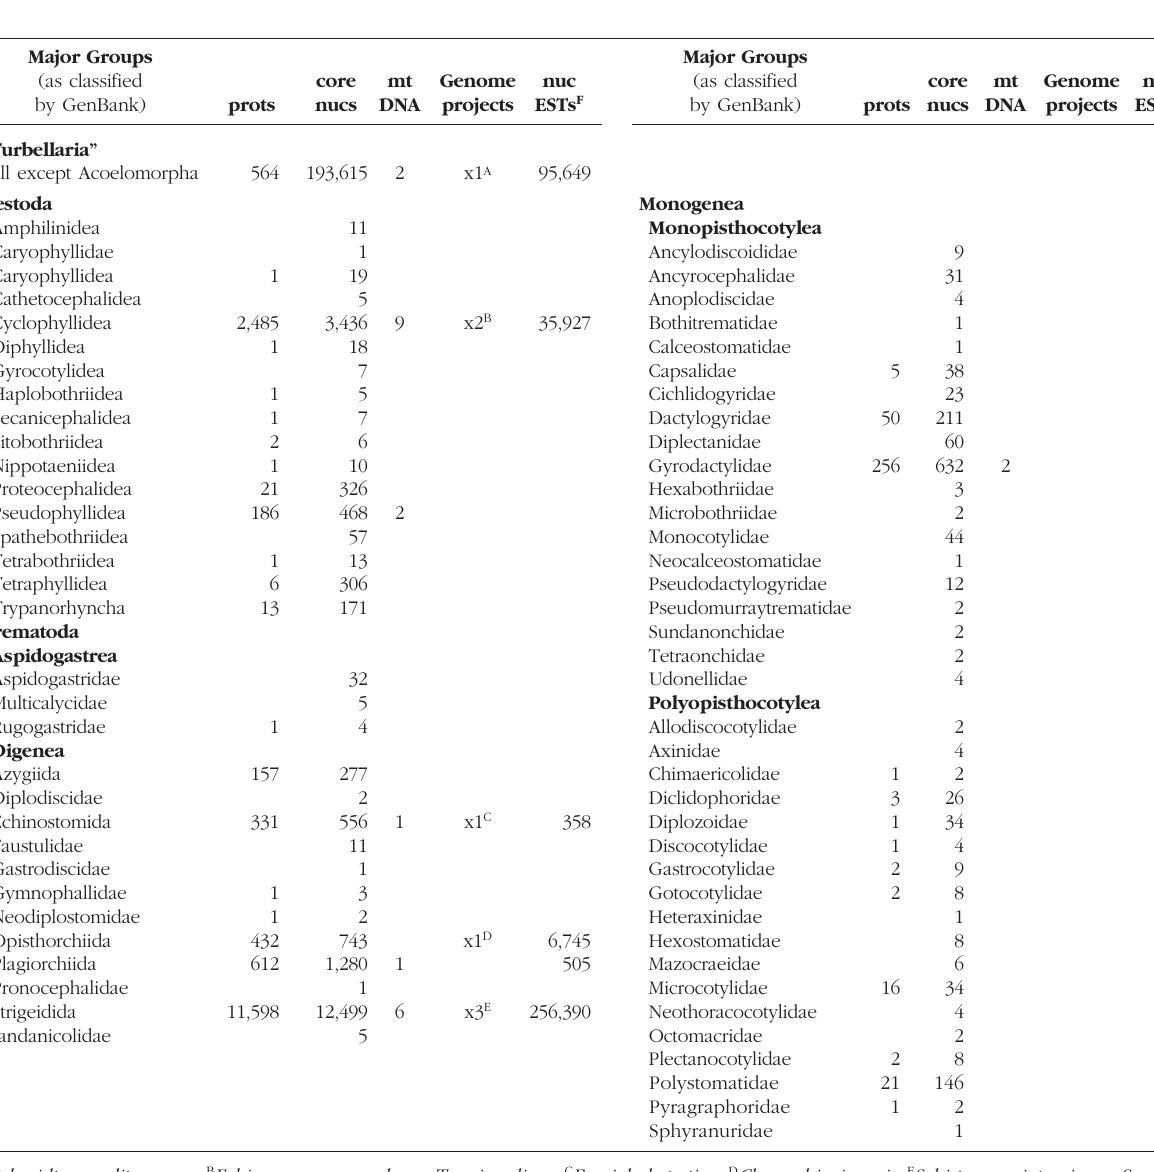
Table II. – Nucleotide, protein, mt genome (mtDNA) and genomic (number of on-going genome projects and Expressed Sequence Tags) effort for parasitic flatworms; data from GenBank (December,